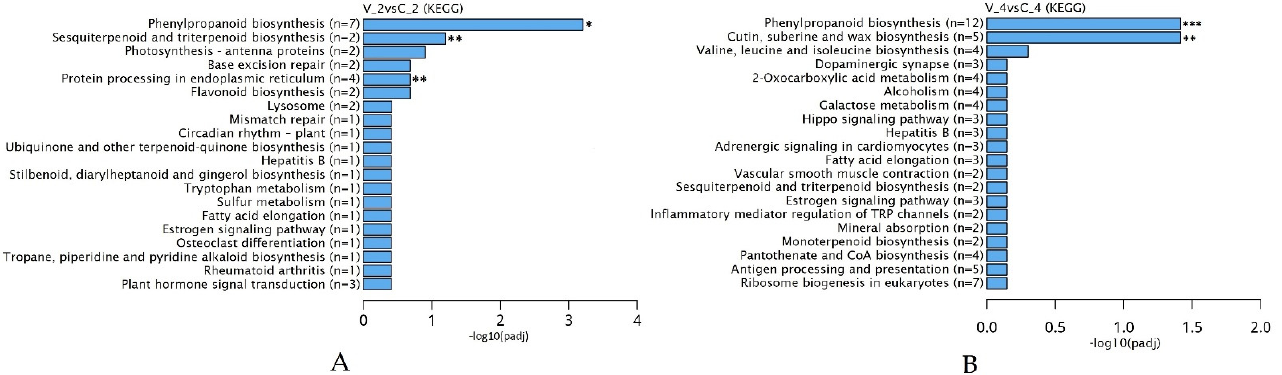
Figure 6. ( A , B ) Kyoto Encyclopedia of Genes and Genomes (KEGG) pathway enrichment analysis of up- and downregulated genes (n = x). All pathways were enriched using the criterion p < 0.05. *— significant upregulation, **—significant downregulation, ***—significant up- and downregulation of the